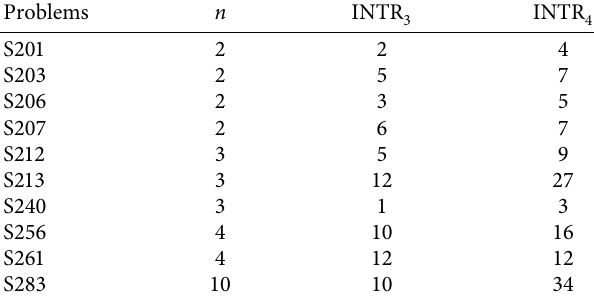
Table 3: The calculation results.